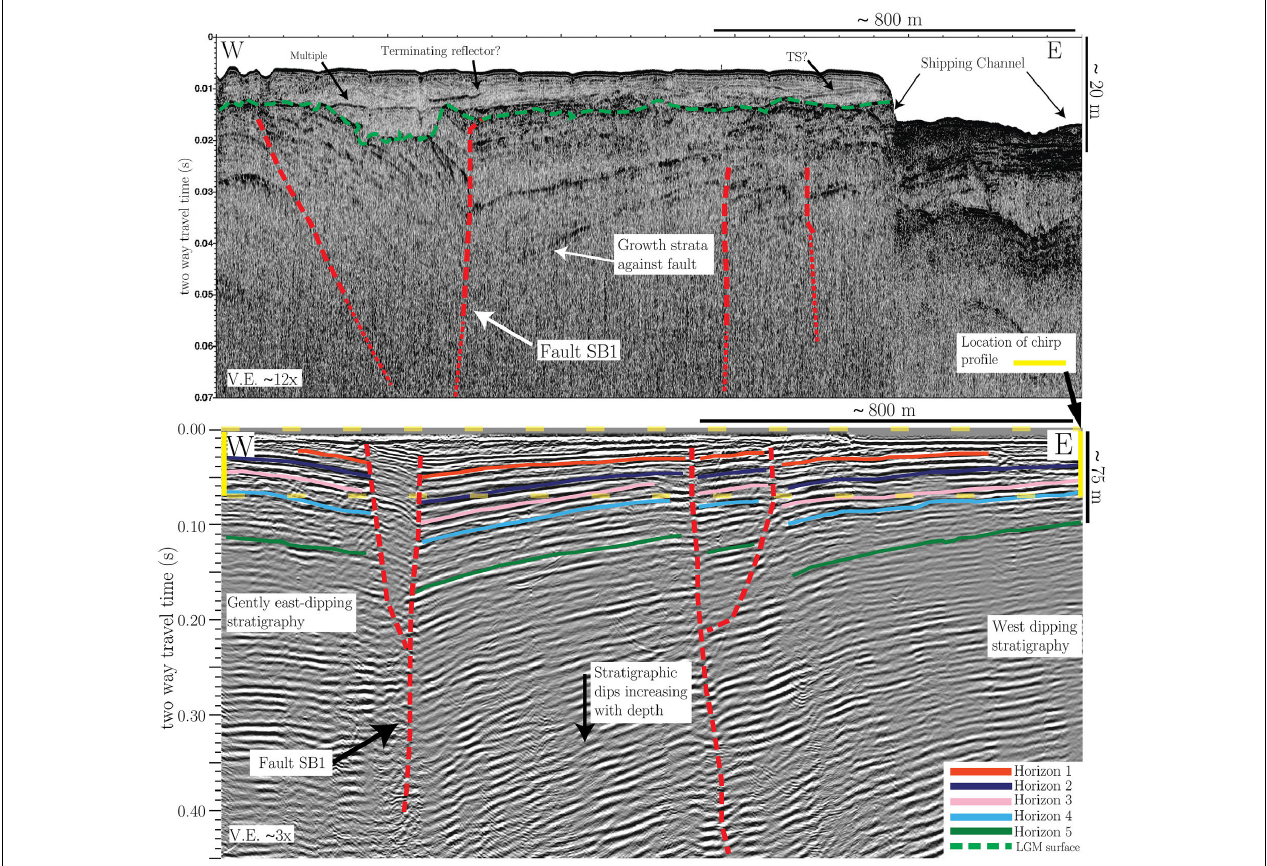
FIGURE 6 | Nested Chirp profile SSB03 (top profile) and MCS profile T196-a792 (bottom profile). Effect of Fault SB1 is seen as increasing dips with depth in the MCS profile, and growth strata terminating against the fault in the Chirp profile. Green dashed horizon in Chirp profile is the interpreted subaerially exposed surface from the Last Glacial Maximum sea level low-stand. Location shown in Figure 2 . See Supplementary Figure 4 for unannotated